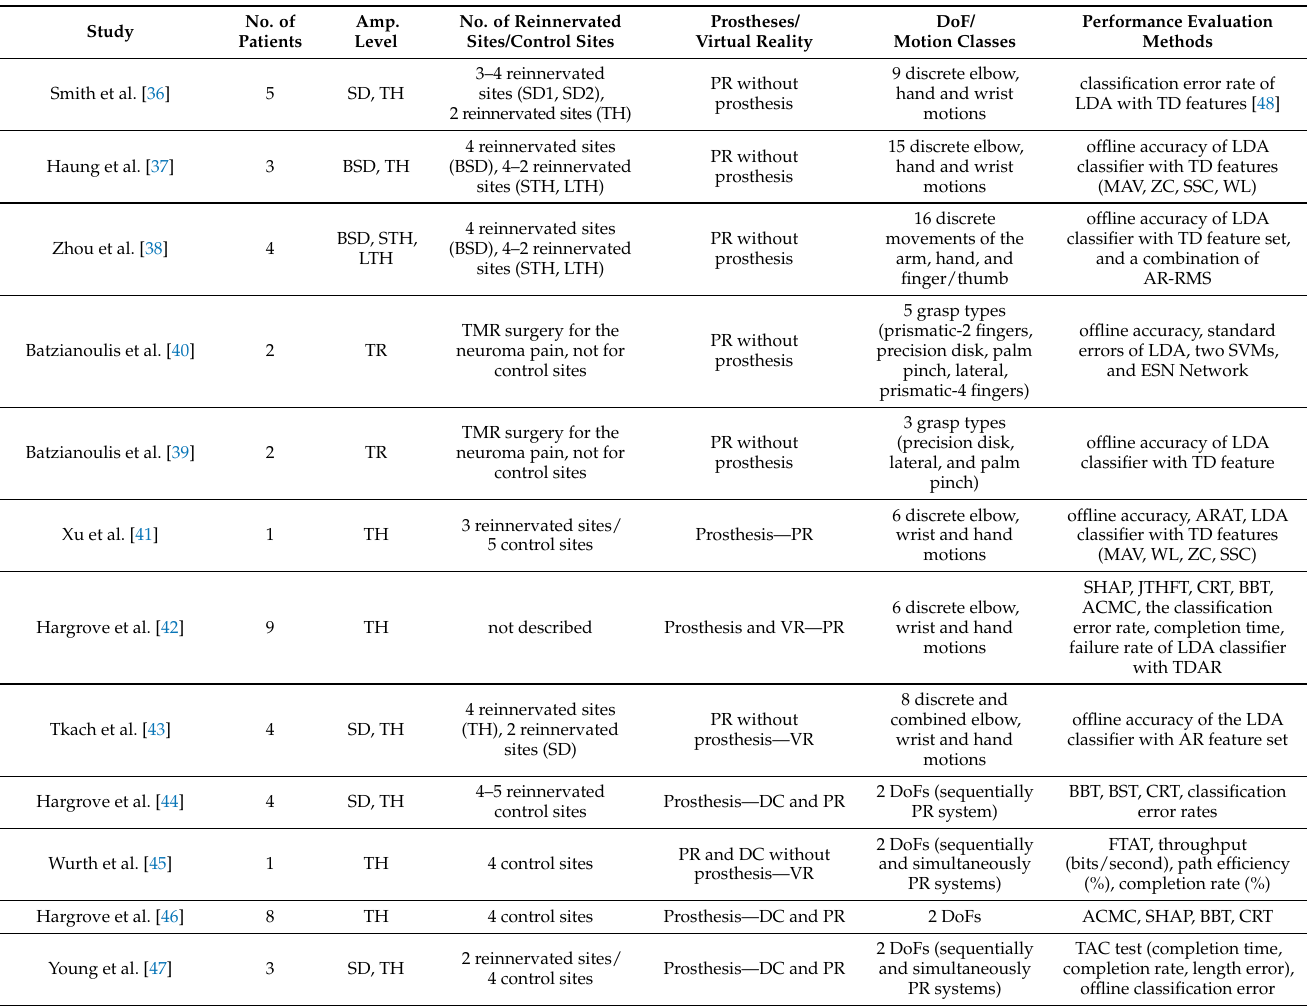
Acronyms of Table 1: BSD: Bilateral Shoulder Disarticulation; SD: Shoulder Disarticulation; TH: Transhumeral; LTH-STH: Long (L)–Short (S) Transhumeral; TR: Transradial; DC: Direct Control; PR: Pattern Recognition; VR: Virtual Reality; BBT: Box and Block Test CRT: Clothespin Relocation Test; WMFT: Wolf Motor Functions Tests; AMPS: Assessment of Motor and Process Skills; LDA: Linear Discriminant Analysis; MAV: Mean Absolute Value; WL: Waveform Length; ZC: Zero Crossing; SSC: Slope Sign Changes; TD: Time Domain; AR-RMS: Auto Regressive-Root Mean Square; ESN: Echo State Network; SVM: Support Vector Machine; TD-AR: Time Domain and Auto Regressive; ARAT: Action Research Arm Test; BST: Block stacking test; FTAT: Fitts’ Target Acquisition Task; SHAP: Southampton Hand Assessment Procedure; JTHFT: Jebsen-Taylor test of Hand